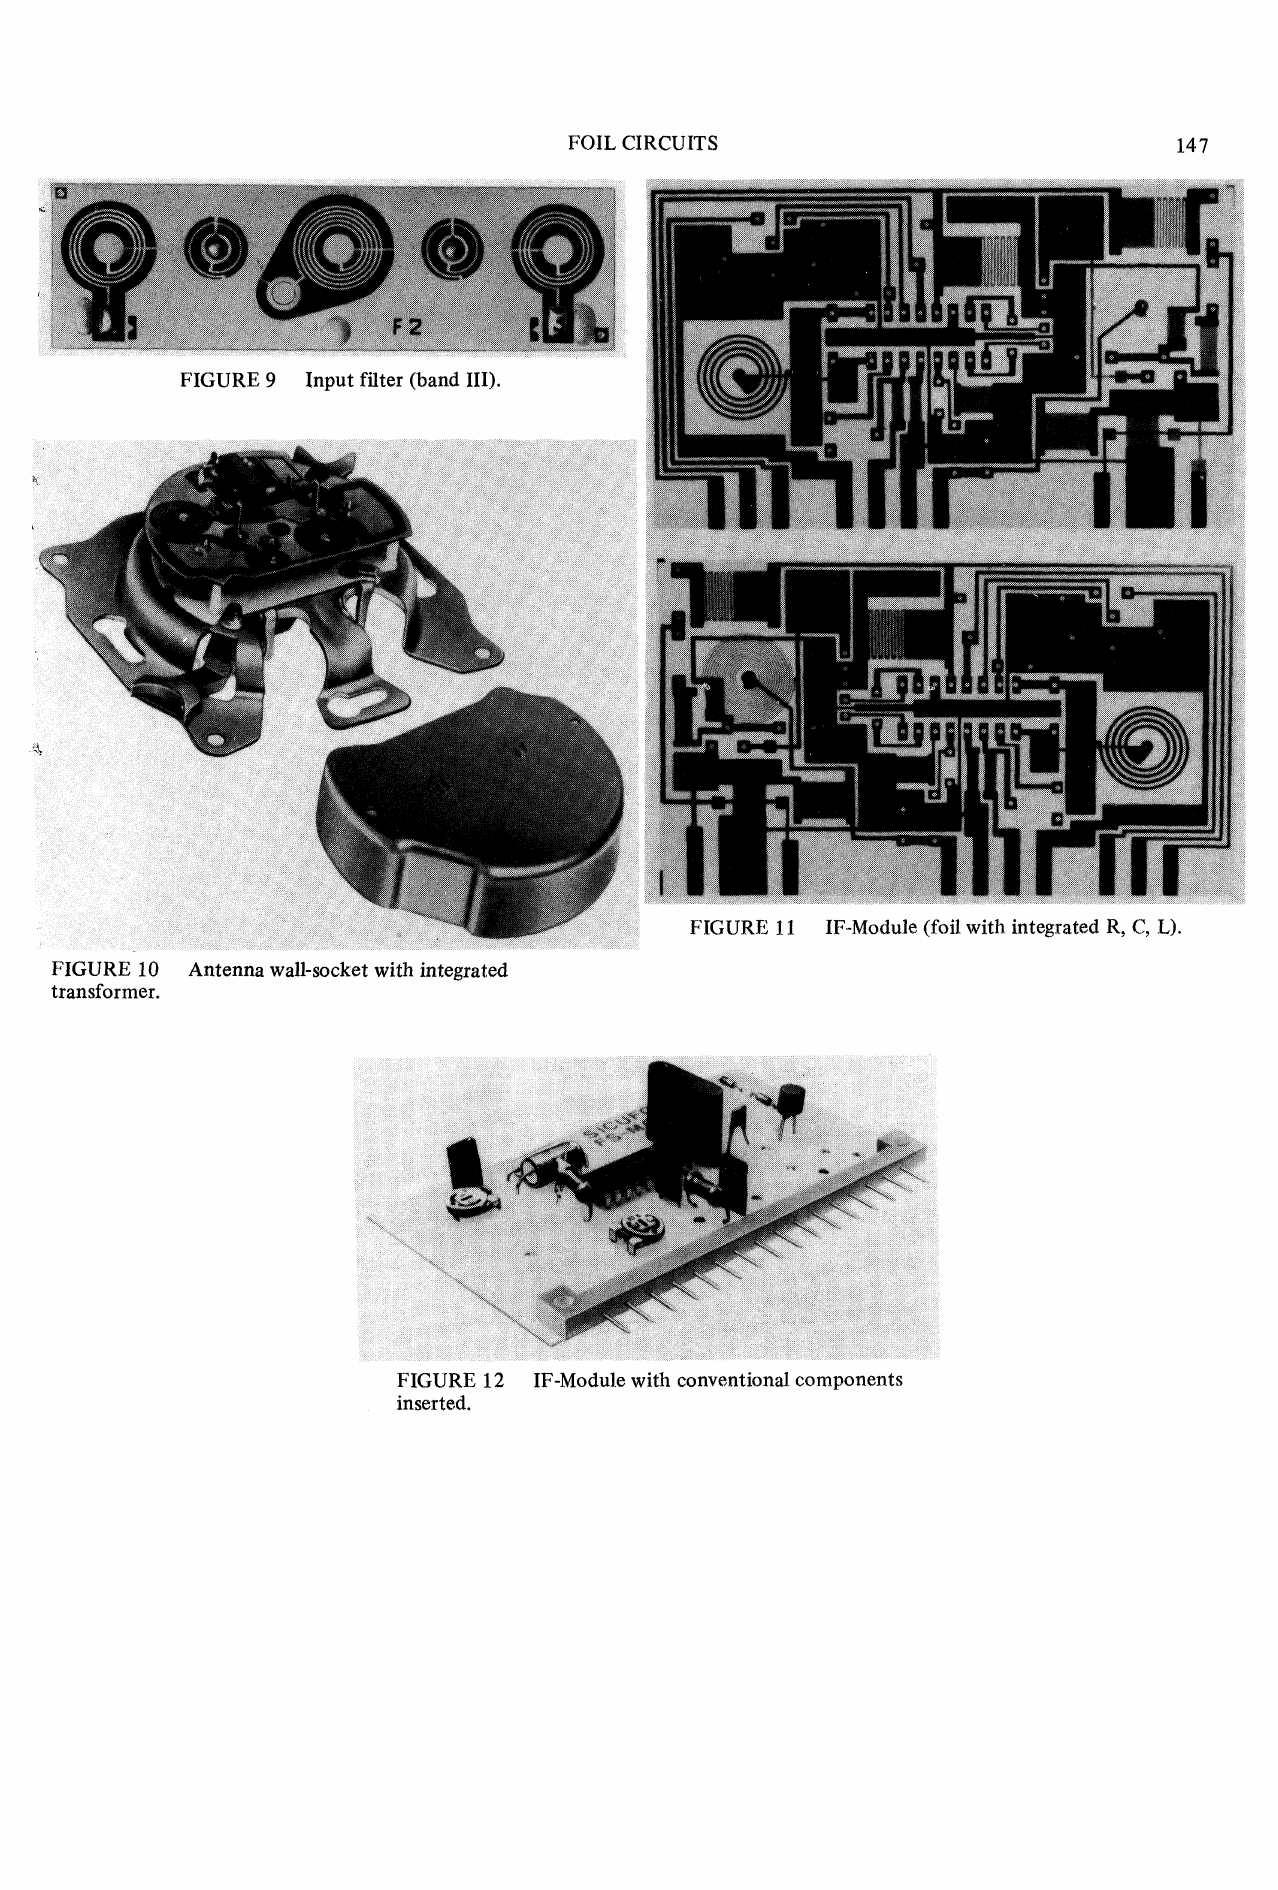
FIGURE 10 Antenna wall-socket with integrated transformer.